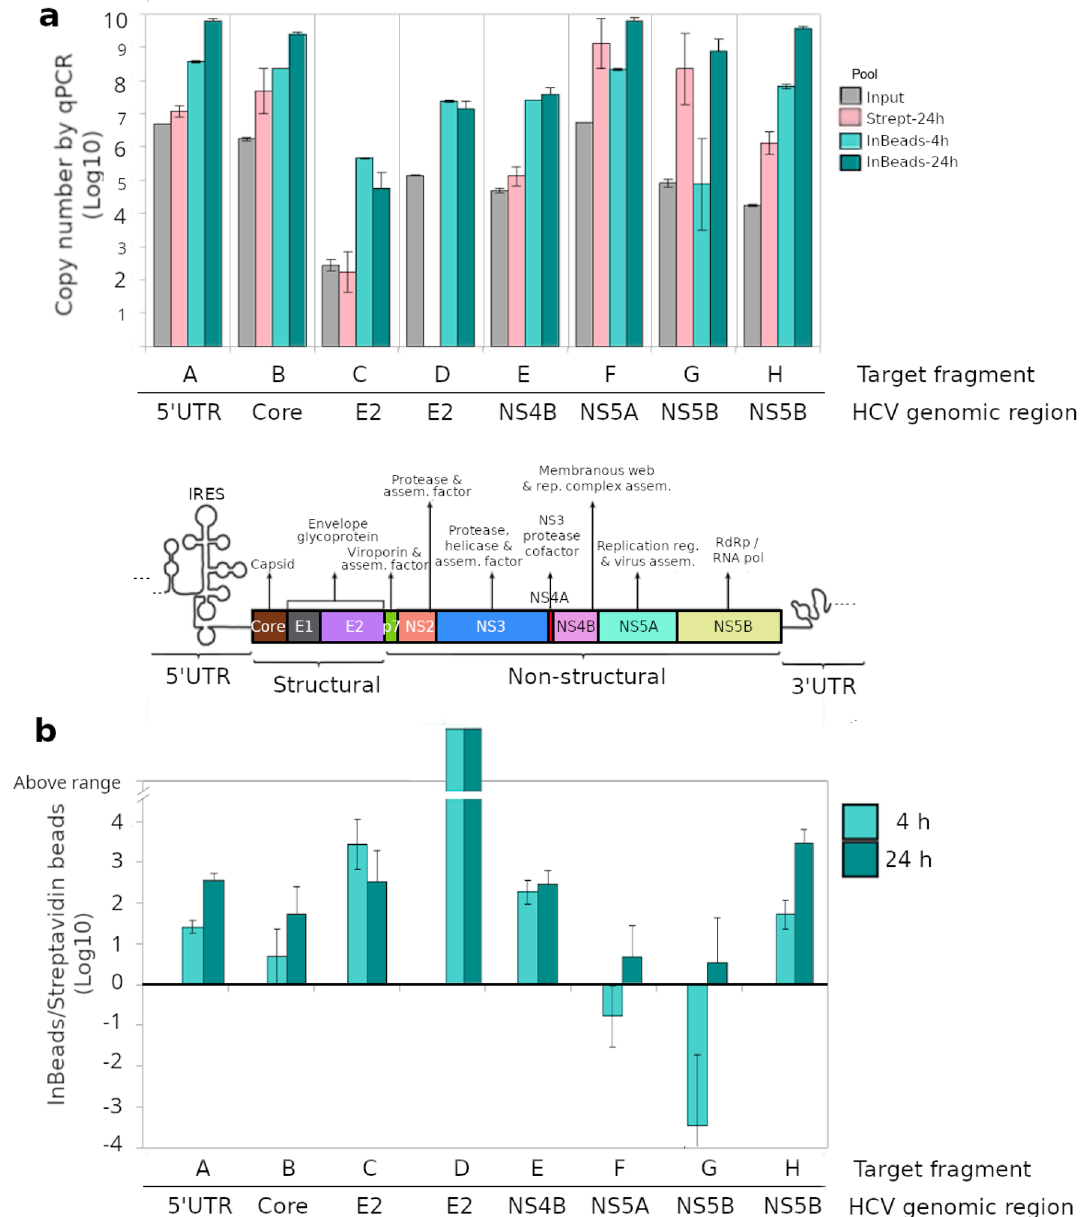
Figure 3. Comparing InBeads with streptavidin beads. Eight regions of the HCV genome (labels A to H) were targeted on one HCV patient (Pt339-1) sample. For InBeads, 4 h and 24 h hybridization times were used. For streptavidin, only 24 h was used. The capture experiments were done 1, 2, and 3 times for InBeads-4 h, InBeads-24 h, and streptavidin-24 h, respectively. ( a ) The copy numbers before and after capture were measured by qPCR, twice for each capture experiment. Data averaging was done on the log transformed values, i.e. geometric means and not arithmetic means. A schematic of the HCV genome shows which genes are in the targeted regions. ( b ) Ratio of InBeads to streptavidin performance. At 24 h, InBeads outperformed streptavidin for all regions, especially for D where streptavidin failed. Even at reduced 4 h hybridization, InBeads outperformed streptavidin in all but two regions (where curiously the error bars seemed larger than other